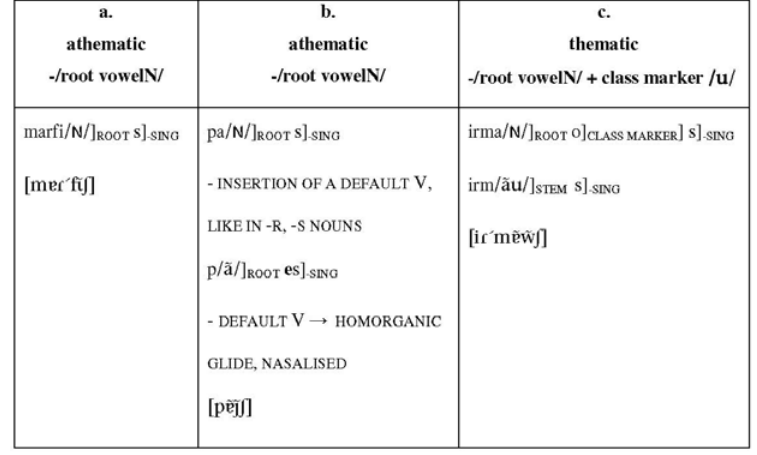
Table 8 – Morphological and phonological structure: -/vowelN/